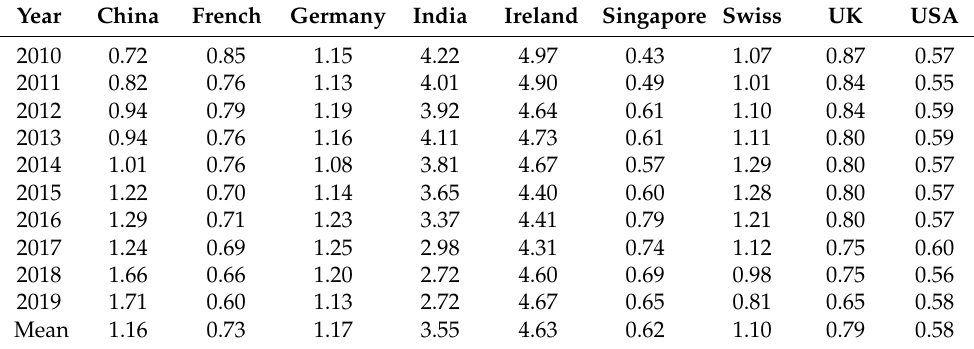
Table 3. RCA index value of computer information services by country.